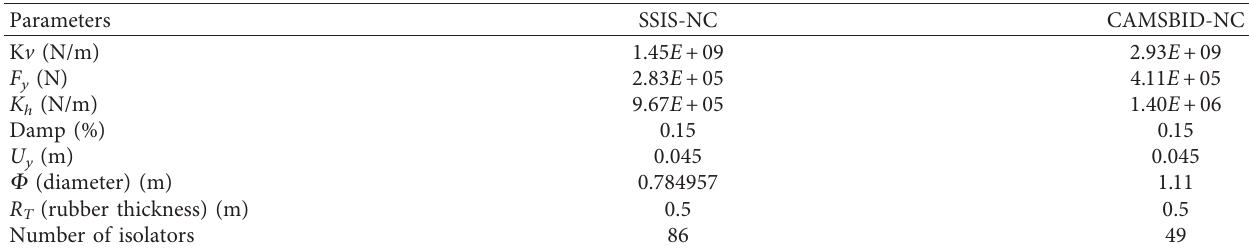
Figure 6: Displacement time-history records of 1999 Duzce-NS (a) and 1995 Kobe-NS earthquake Table 3: Properties of seismic LCRB isolators for SSIS-NC and CAMSBID-NC structures.